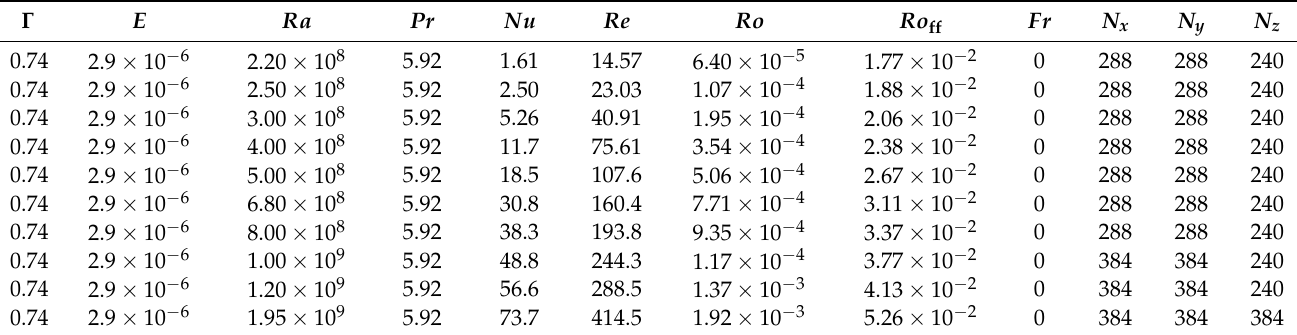
Table A3. Non-dimensional values of DNS in this study: Γ is the aspect ratio, E is the Ekman number, Ra is the Rayleigh number, Pr is the Prandtl number, Nu is the Nusselt number, Re is the Reynolds number, Ro is the Rossby Number, Ro c is the convective Rossby number given as Ro c = √ RaE 2 / Pr , Fr is the Froude number, and N x , N y , and N z are the number of grid points in the x -, y -, and z -directions,